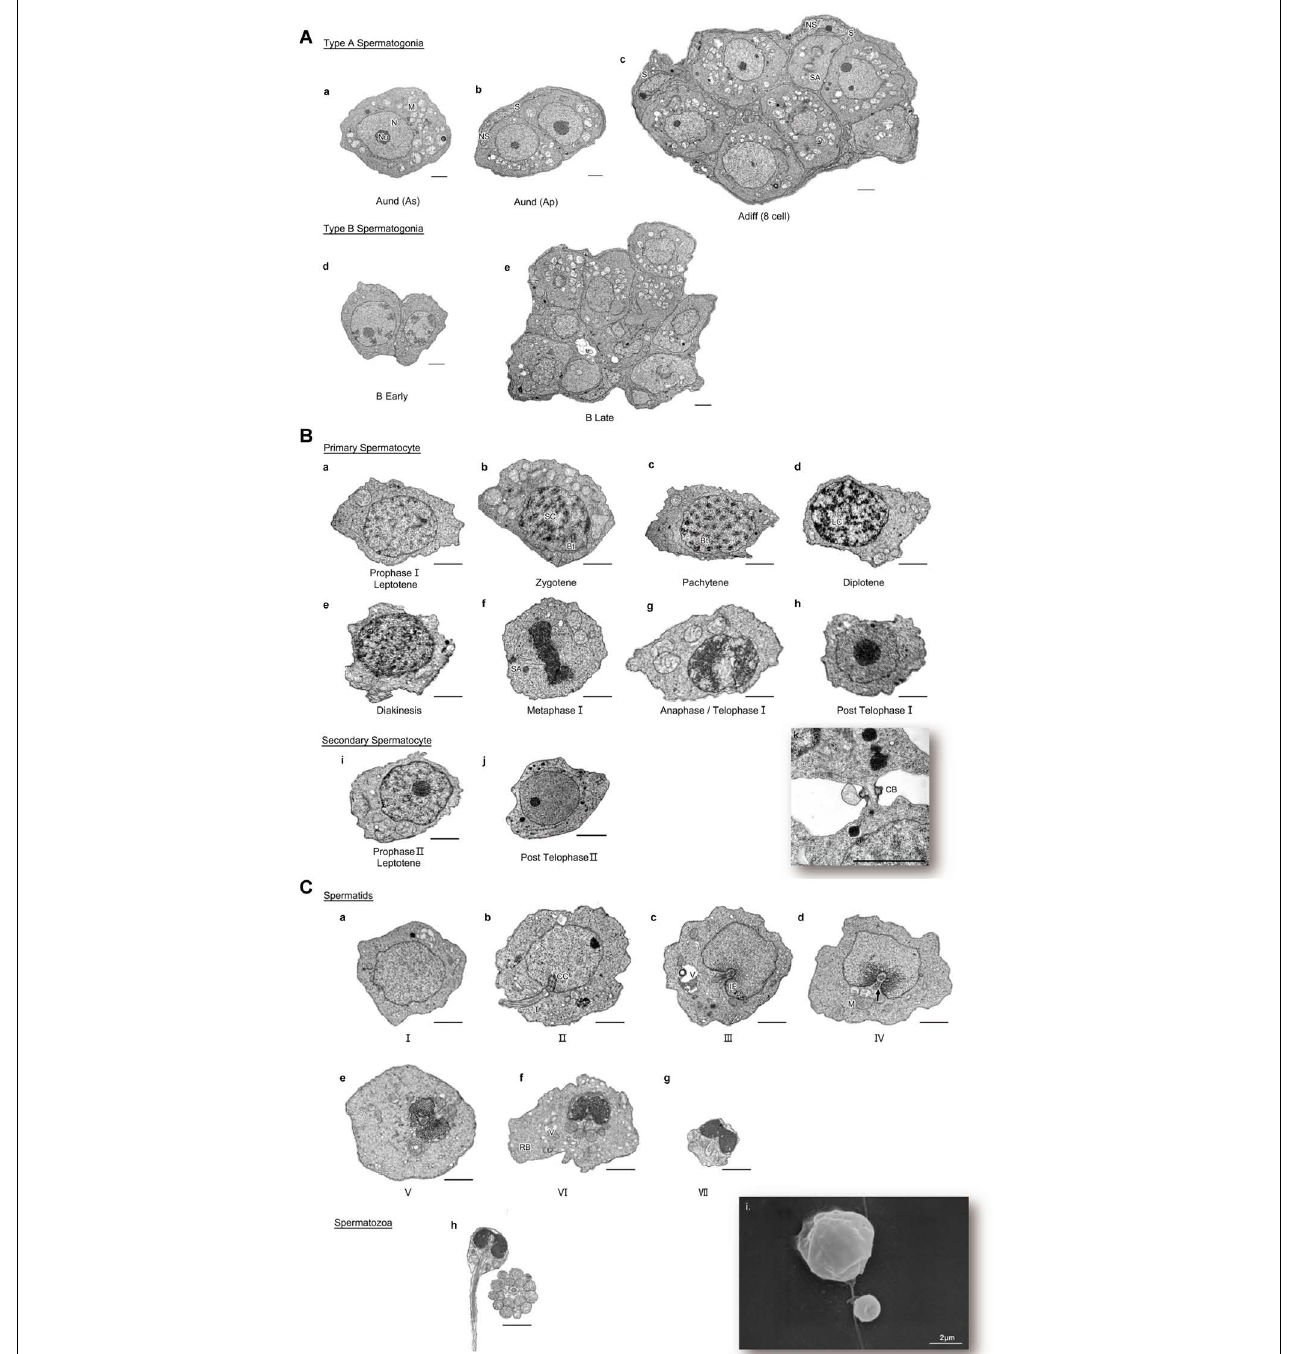
FIGURE 3 | (A) Different developmental stages of spermatogonia. (a-c) type A spermatogonia; (a) type A undifferentiated spermatogonia (single) [Aund (As)]; (b) type A undifferentiated spermatogonia (paired) [Aund (Ap)]; (c) type A differentiated spermatogonia [Adiff (8cell)]; (d,e) type B spermatogonia; (d) B Early; (e) B Late. N, nucleus; Nu, nucleolus; M, mitochondria; S, Sertoli cell; NS, nucleolus of Sertoli cell; SA, spindle apparatus. TEM. Scale bar 2 µ m. n = 6. (B) Different developmental stages of spermatocyte. (a-h) primary spermatocyte; (a) Prophase I Leptotene; (b) Prophase I Zygotene; (c) Prophase I Pachytene; (d) Prophase I Diplotene; (e) Prophase I Diakinesis; (f) Metaphase I; (g) Anaphase/Telophase I; (h) Post Telophase I; (i,j) secondary spermatocyte; (i) Prophase I Leptotene; (j) Post TelophaseII; (k) cytoplasmic bridge between two spermatocytes. SC, synaptonemal complex; Bt, bivalent; LC, lampbrush chromosome; SA, spindle apparatus; CB, cytoplasmic bridge. TEM. Scale bar 2 µ m. n = 6. (C) Process of spermiogenesis showed different stages of spermatids and spermatozoa. (a–g) Spermatid I – VII; (h) Spermatozoa; (i) SEM of SpermatidII and Spermatozoa. CC, centrosome complex; T, tail; IF, implantation fossa; V, vesicle; M, mitochondria; RB, residual body; arrow: central space of sleeve. TEM, SEM. Scale bar 2 µ m. n =